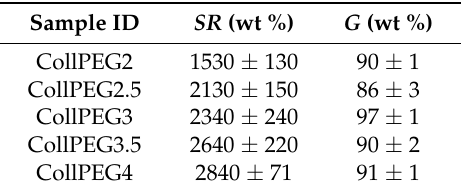
Table 3. Swelling ratio and gel content of the thiol-ene collagen-PEG hydrogels. Data represented as mean ± SEM.